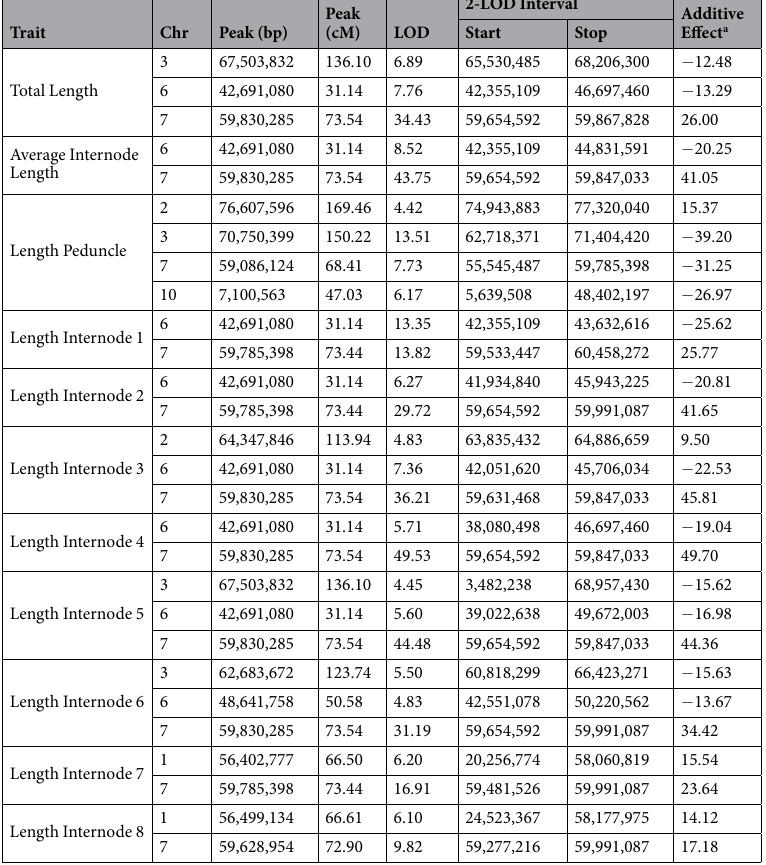
Table 1. QTL Segregating for Stem Traits in the BTx623 x IS3620c RIL Population. Internodes are numbered from the peduncle. Chromosome is abbreviated as “Chr”. a A positive effect indicates that the IS3620c allele increases length.